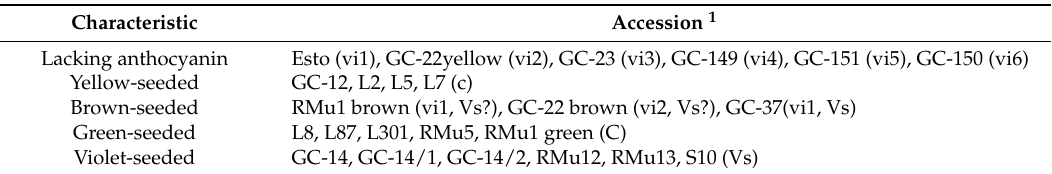
Table 3. Plant material used in the